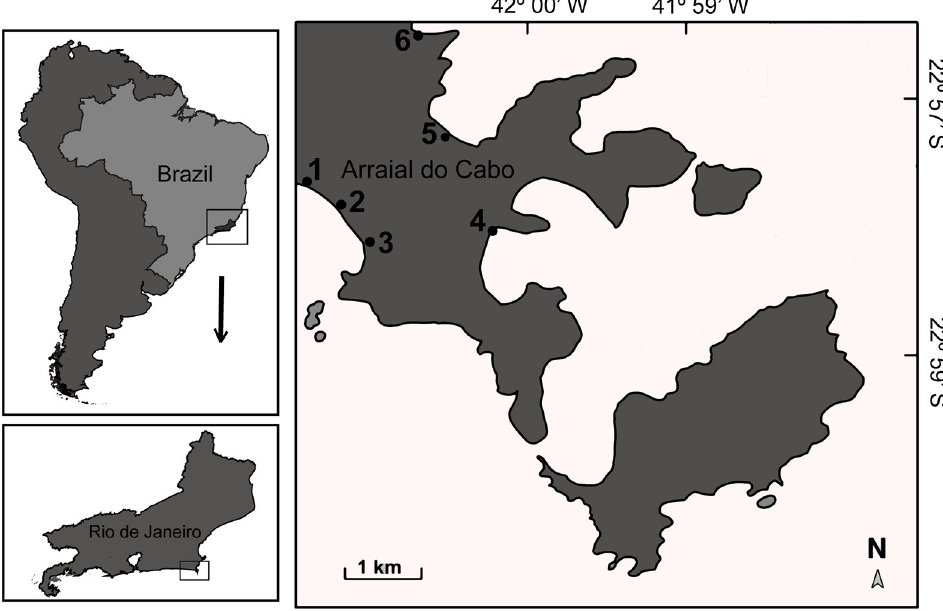
Fig 1. Map of Arraial do Cabo region (state of Rio de Janeiro, Brazil), showing interview sites. Map reprinted from [54] under a CC BY license, with permission from Bender et al (2014), original copyright 2014.